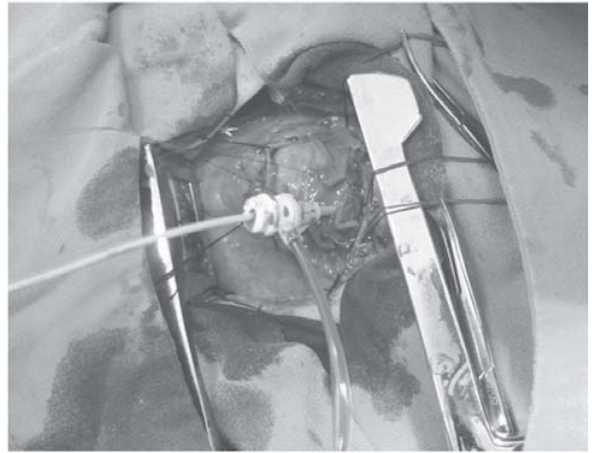
Fig. 2 – Minitoracotomia ântero-lateral esquerda com exposição do ápice ventricular esquerdo. Introdutor posicionado